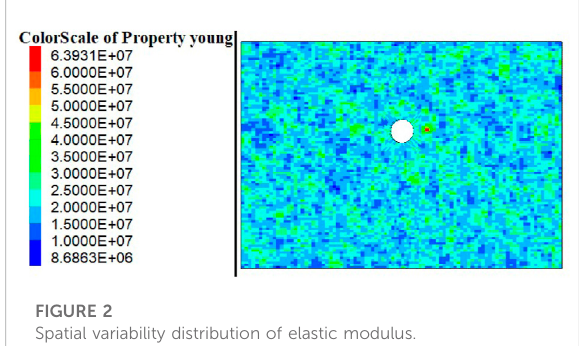
FIGURE 2 Spatial variability distribution of elastic